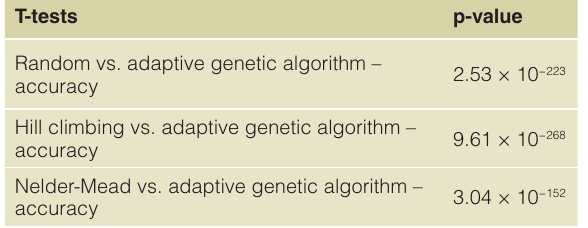
Table 7. Summary of results and statistics comparing run times for accurate and inaccurate convergences using the Hill climbing and Nelder-Mead